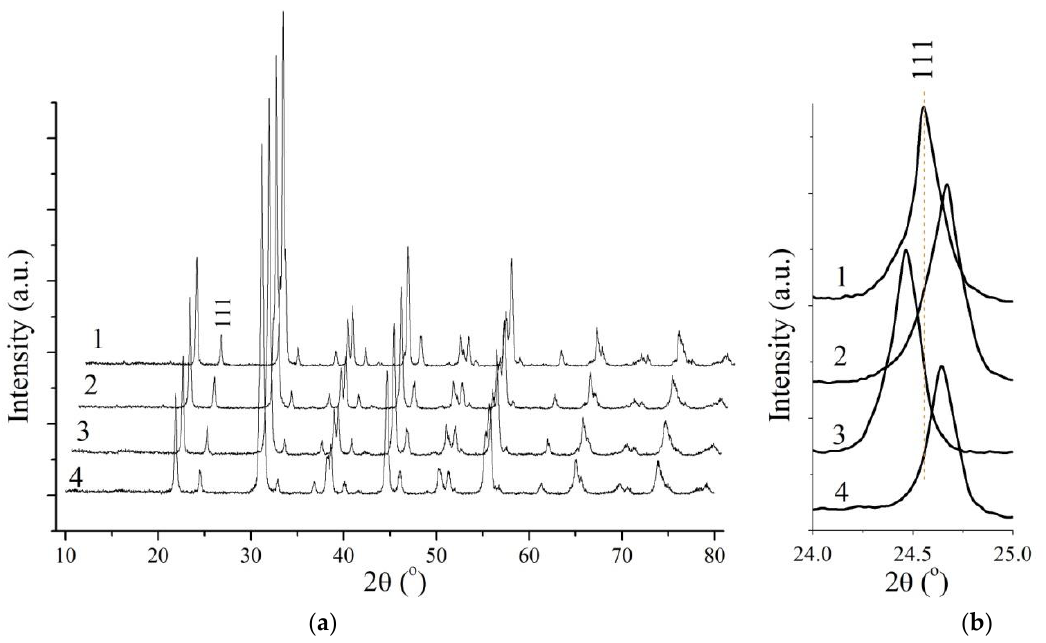
Figure 3. ( a ) The XRD patterns of new phase La 2 ScZnO 5.5 (1) and doped phases La 2 Sc 0.9 Mg 0.1 ZnO 5.45 (2), La 2 Sc 0.9 Ca 0.1 ZnO 5.45 (3), La 1.9 Ca 0.1 ScZnO 5.45 (4); ( b ) shifts of the diffraction peak (111)